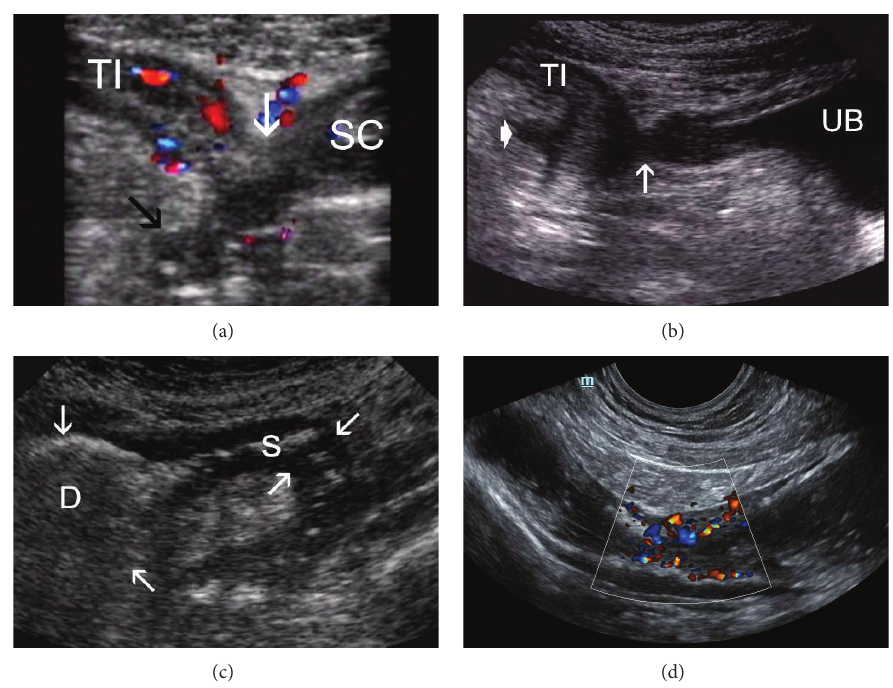
Figure 3: Crohn’s disease complications. (a) Transverse view in lower abdomen shows fistula (white arrow) between terminal ileum/TI) and sigmoid colon (SC), black arrow points to small abscess, high resolution probe . (b) Oblique section of terminal ileum (TI) with blind fistula (thick arrow) into echogenic mesenterial fat and ileovesical fistula (thin arrow). Standard abdominal probe . (c) Stricture of ileum (S) with prestenotic dilatation (D)— standard abdominal probe . (d) TUS with color doppler and peroral contrast—Crohn’s terminal ileum stenosis with intramural hypervascularisation (with CFD) indicates inflammatory stenosis— high resolution probe.